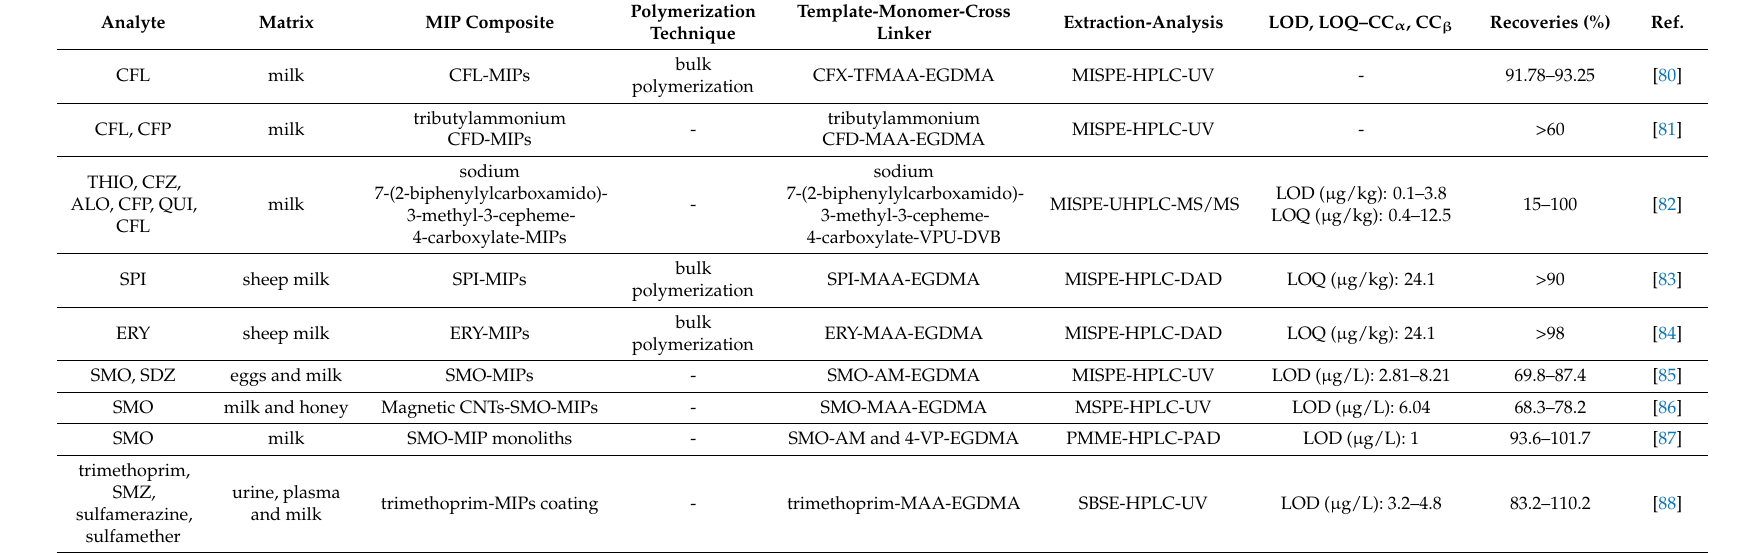
Table 5. MIPs applications for the determination of cephalosporins, macrolides and sulfonamides in milk